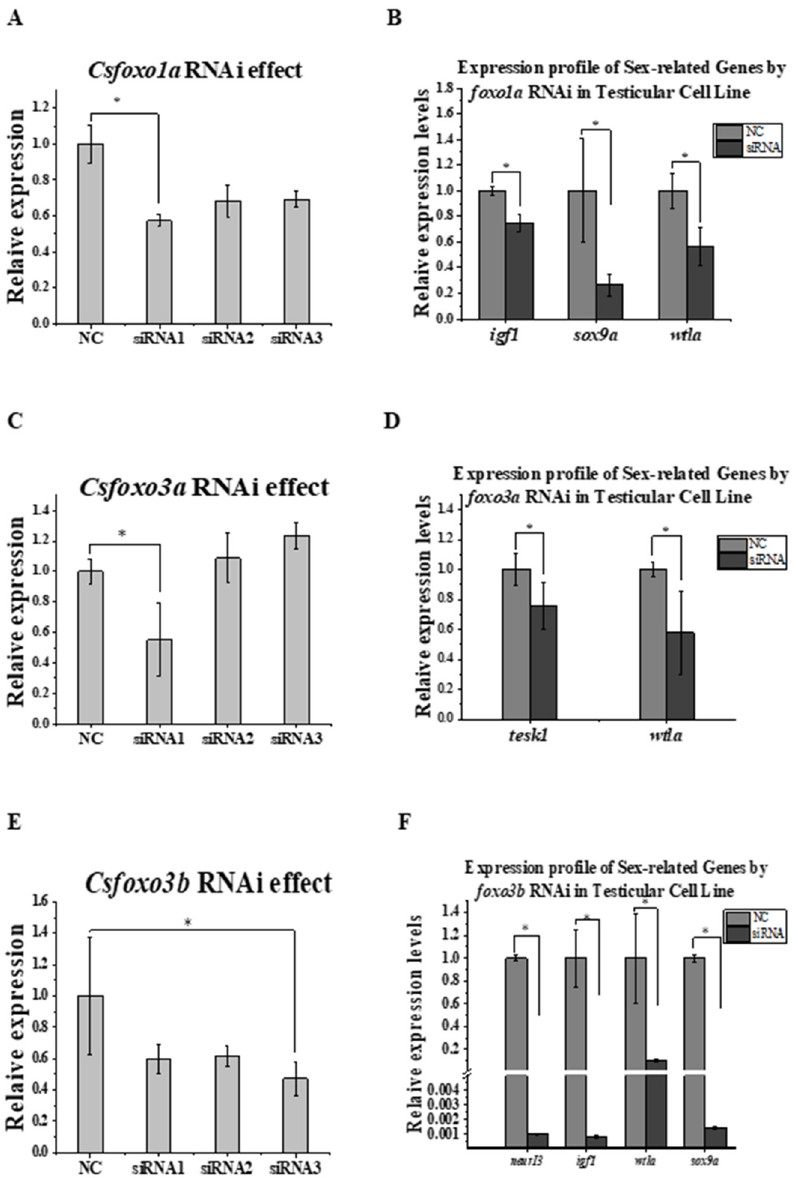
Figure 6. Effects of the knockdown of the genes Csfoxo1a , Csfoxo3a , and Csfoxo3b in a testicular cell line. ( A ) The effect of the knockdown of three siRNAs on Csfoxo1a . ( B ) The effect of the knockdown of Csfoxo1a on other genes. ( C ) The effect of the knockdown of three siRNAs on Csfoxo3a . ( D ) The effect of the knockdown of Csfoxo3a on other genes. ( E ) The effect of the knockdown of three siRNAs on Csfoxo3b . ( F ) The effect of the knockdown of Csfoxo3b on other genes. * indicates significant dif- ferences.